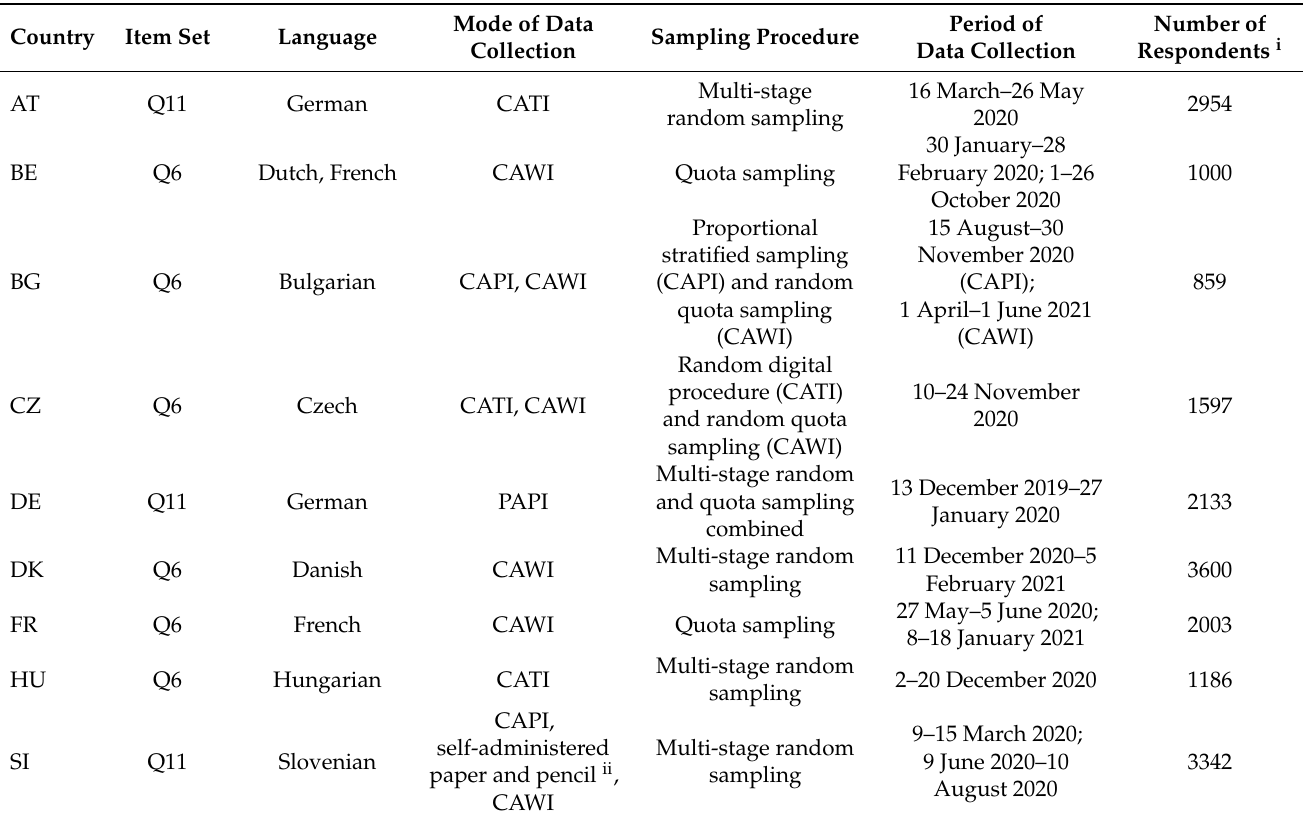
Table 2. Main characteristics of data collection in countries measuring communicative health